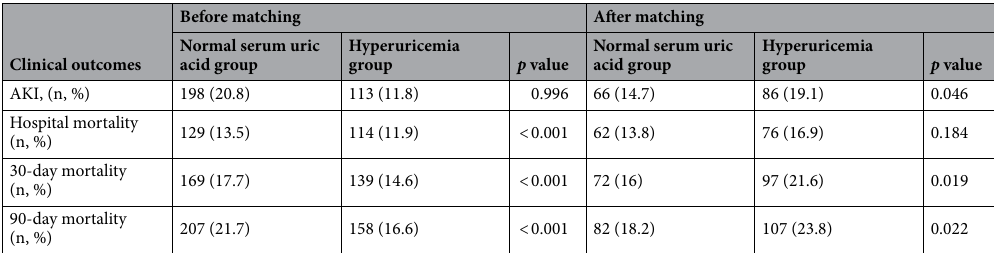
Table 2. Clinical outcomes before and after propensity-score matching population. AKI acute kidney injury. Chi-square test and Wilcoxon rank-sum test were used to compare the differences of categorical and continuous variables respectively.